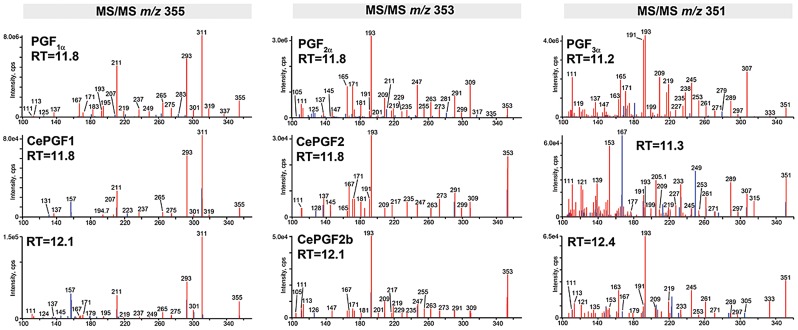
Collision induced decomposition patterns of selected C. elegans and human prostaglandins.LC-MS/MS of authentic standards (top) compared to selected C. elegans prostaglandins highlighted in Figure 3A. Red color indicates ions shared by the standard and an unknown prostaglandin. Blue color indicates ions that are not shared. m/z is on the X-axis. C. elegans MS/MS data are from fat-1(wa9) fat-4(wa14) mutant extracts (F1 class), fat-1(wa9) extracts (F2 class), and wild-type extracts (F3 class). RT, retention time.